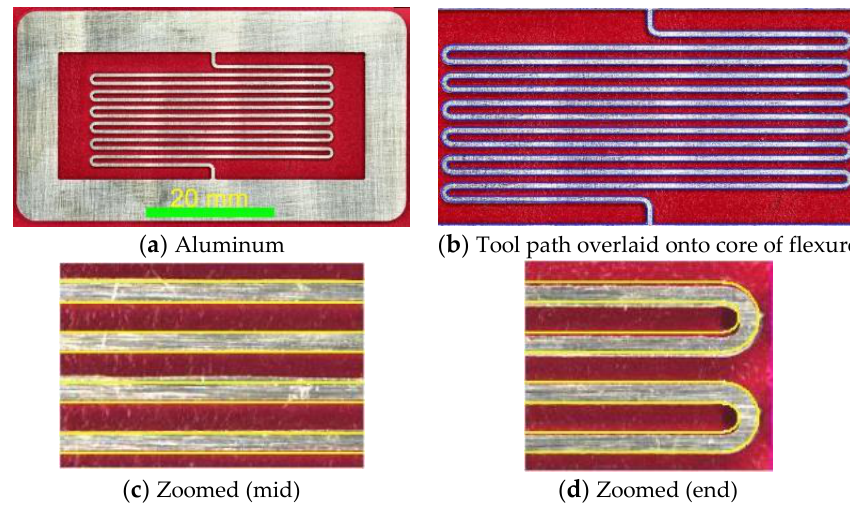
Figure 5. Aluminum flexure – Zund (CBA).